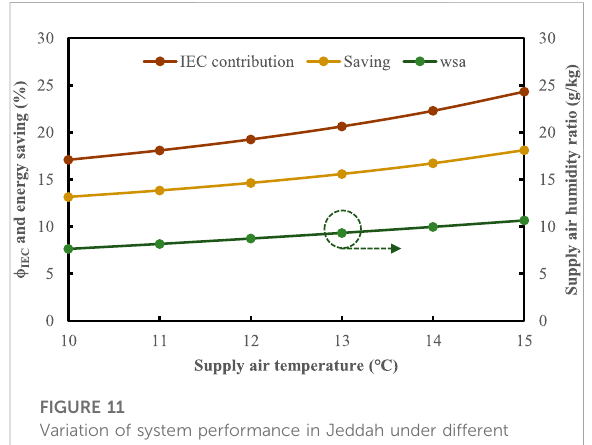
FIGURE 11 Variation of system performance in Jeddah under different set points for supply air temperature.